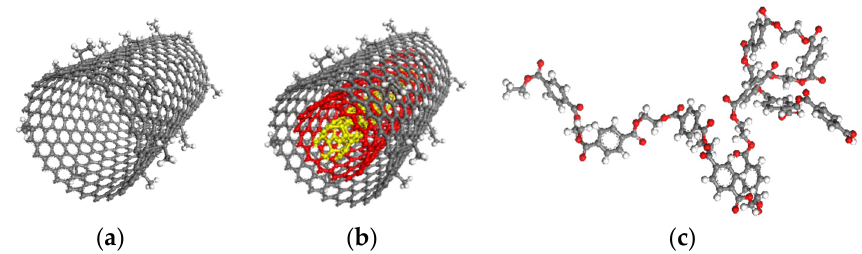
Figure 1. Molecular models of ( a ) (23,0) single-walled carbon nanotubes (SWNT), ( b ) (23,0), (14,0), (5,0) multi-walled carbon nanotubes (MWNT), and ( c ) polyethylene terephthalate (PET) chain.